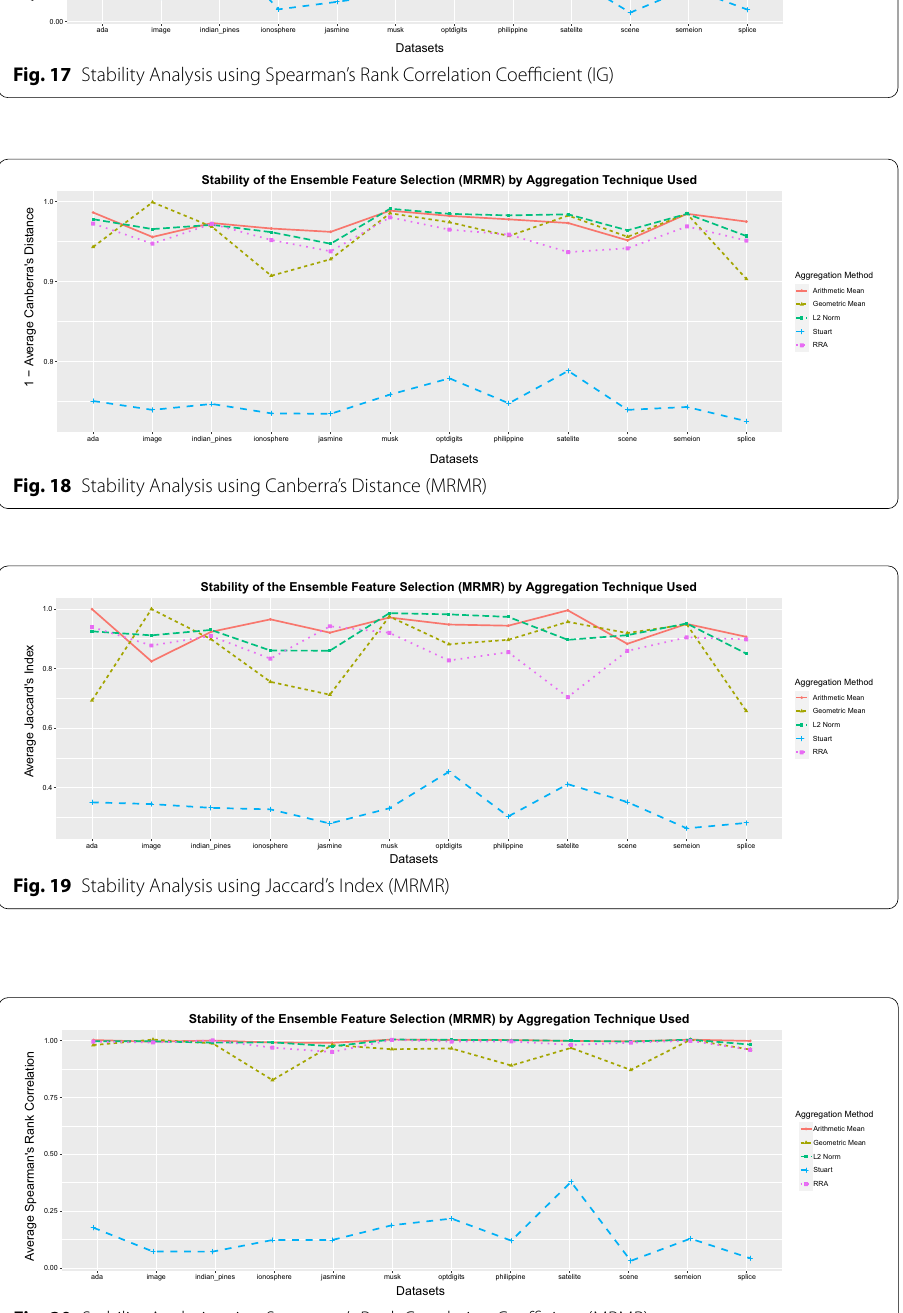
Fig. 20 Stability Analysis using Spearman’s Rank Correlation Coefficient